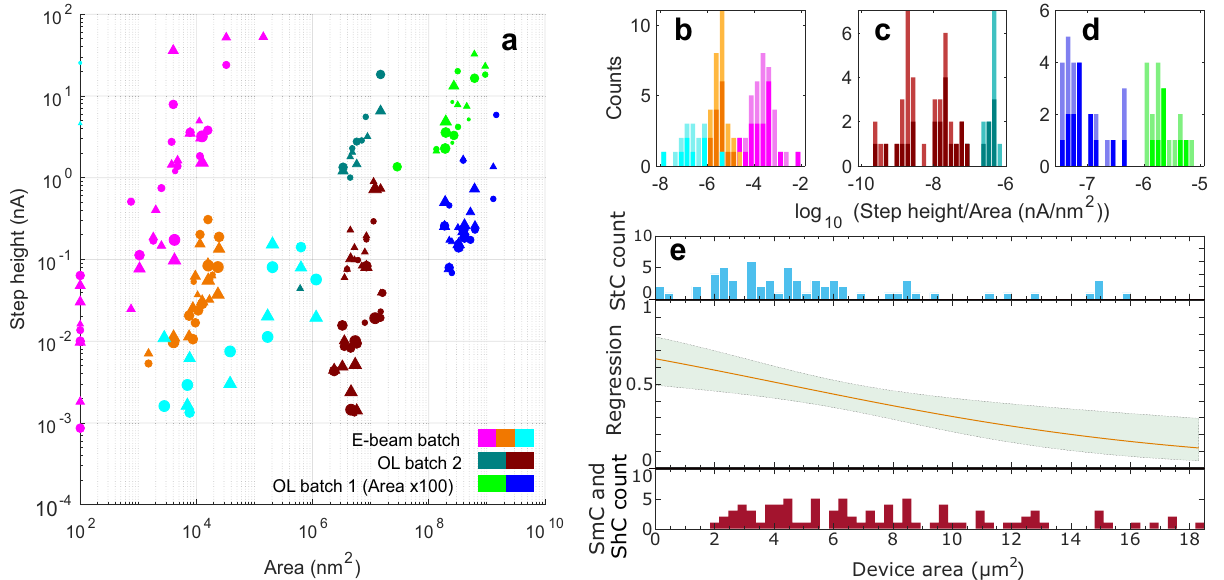
Fig. 3 Correlation of step height and probability with area. a Current heights of the fi rst positive-bias (circles) and negative-bias (triangles) steps vs device area, for all StC.The size of each data point corresponds to the quality of the I – V trace: larger points represent higher-quality StC with more steps, less noise and/or sharper steps. Devices with areas <100 nm 2 are shown at 100 nm 2 . OL batch 1 is offset laterally by a factor of 100 for clarity. The data cluster into groups and show a positive correlation when devices are split into 36-sample fabrication batches. Within each batch there is an additional separation into discrete conduction groups, each displaying a different range of current step heights. b – d Histograms of step height divided by area for each batch in ( a ), with matching colours, showing that the distributions have widths of at most an order of magnitude. e Logistic-regression analysis estimating the probability of StCs for different OL areas. Various independent variables have been tested, including types of device perimeter, but device area is the best predictor of StC and ShC with a p value of 0.00177. In the analysis, StC (SmC and ShC) are represented as 1 (0). Green banding around the probability line shows the 95% con fi dence interval across the area range. Histograms above and below the regression line show the curve-type counts for different device areas. Reducing the device area from 18 to <1 μ m 2 increases the probability of measuring a StC from 0.12 to